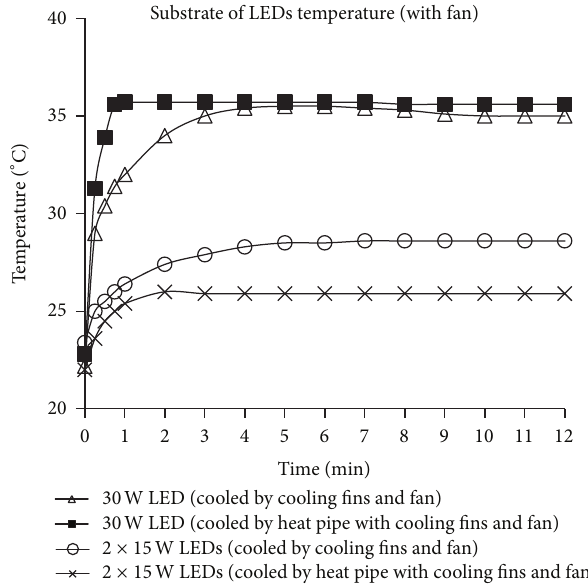
Figure 7: The change of the substrate of LED temperature overtime during the cooling process of LEDs with 30W and 2 × 15 W LEDs configuration as a means of integrated fin heat sink design with fan and heat pipe cooling device.